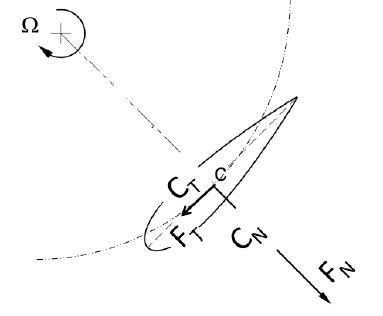
Figure 7. Representation of the blade normal C N and tangential C T